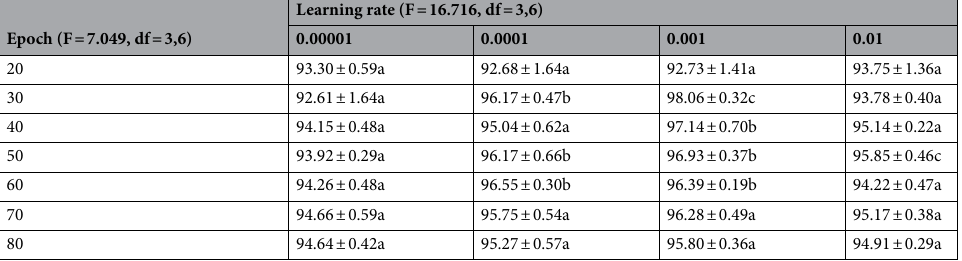
Table 1. Hyperparameter analysis of testing accuracy (%, means ± S.E.) of the proposed model. Means ± S.E followed by same letter indicates not significantly different at P = 0.05 within row, post hoc test, Turkey. Epochs*Learning rate (F = 2.525, df = 18). SE Standard